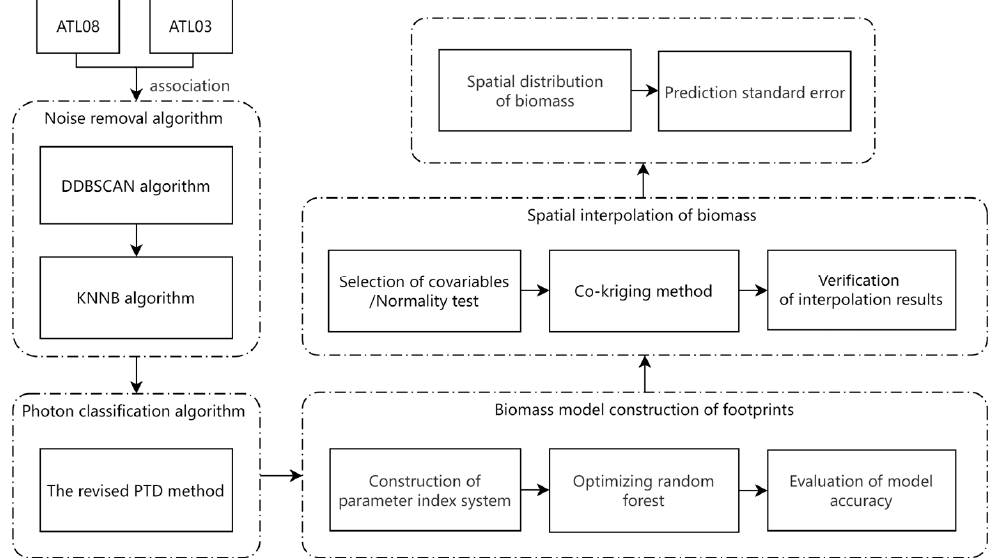
Figure 4. Technology roadmap.